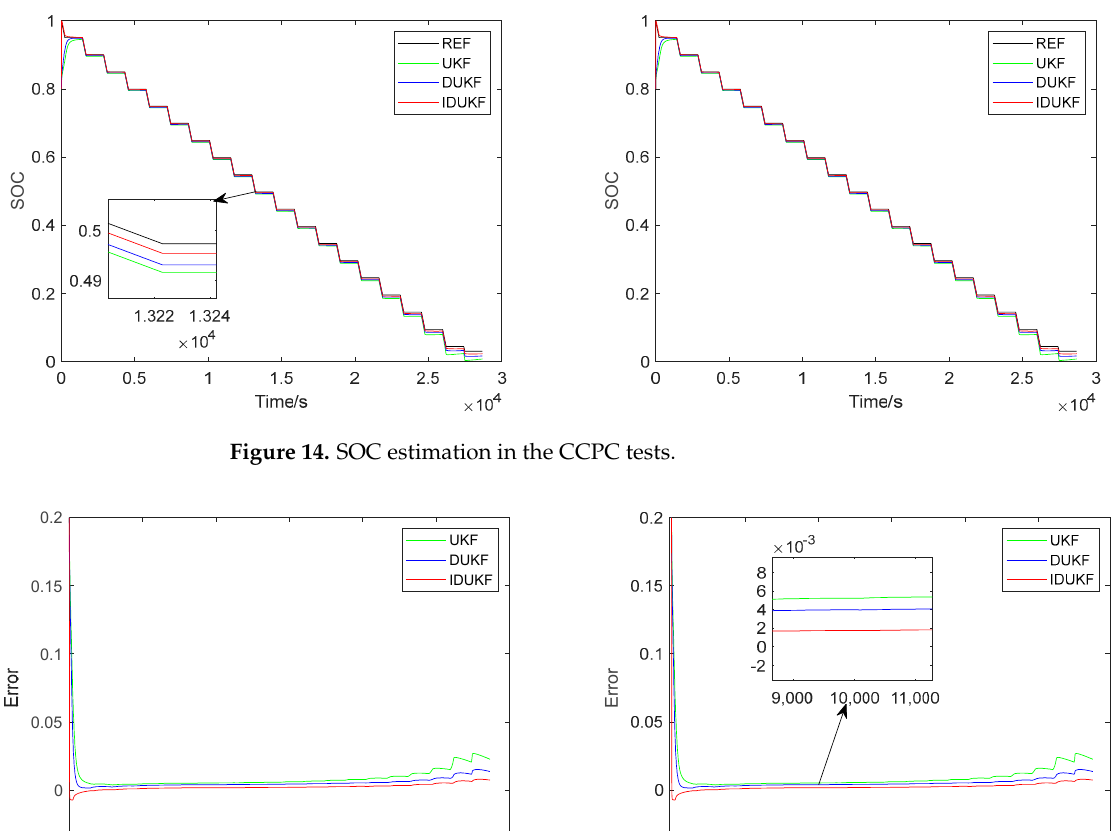
Figure 13. The predicted results of the SOH.